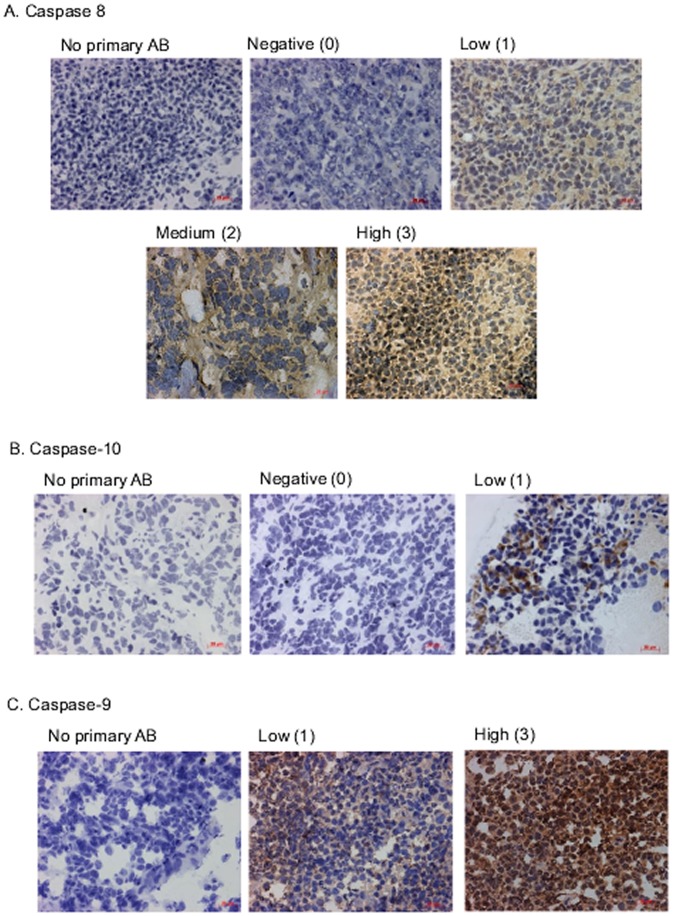
Immunohistochemistry on primary ESFT (5 µm) for caspases-8, -9 and -10.Immunohistochemistry in the absence of primary antibody was to control for non-specific binding of the secondary antibody (No primary AB). Magnification of images = ×400. Caspase expression was scored as negative (0), low (1), medium (2) or high (3). A. Caspase-8 protein expression. B. Caspase-10 protein expression. C. Caspase-9 protein expression.